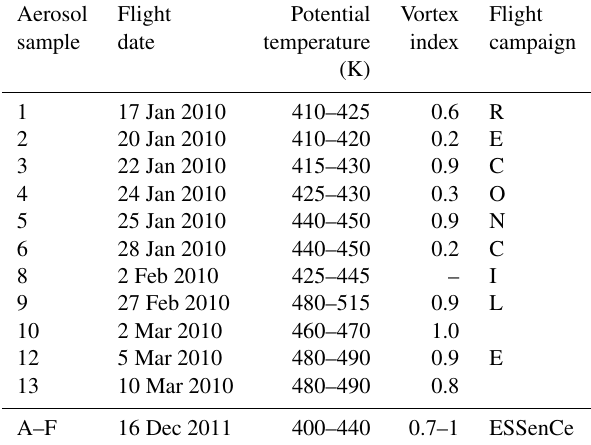
Figure 2. Potential temperature range, vortex situation and pres- ence of polar stratospheric clouds for the 11 aerosol samples for RECONCILE (2010) and the ESSenCe sample